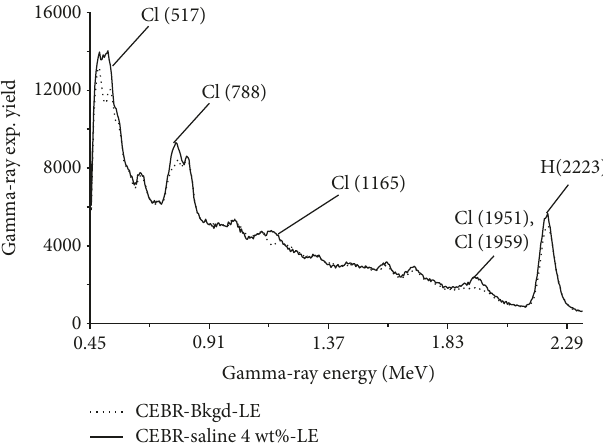
Figure 7: Low-energy pulse height spectrum of the CeBr contaminated water sample superimposed upon background